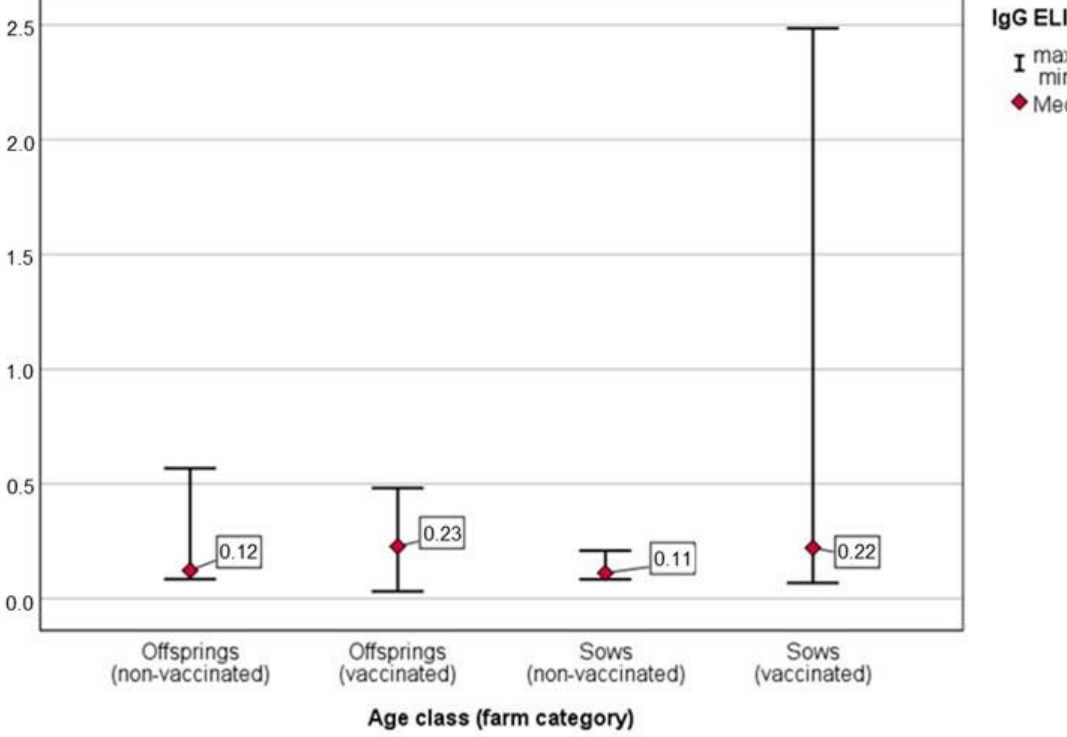
Figure 2. IgG and IgA ELISA OD value in the oral fluid samples from vaccinated and non-vaccinated farms (all pig categories).